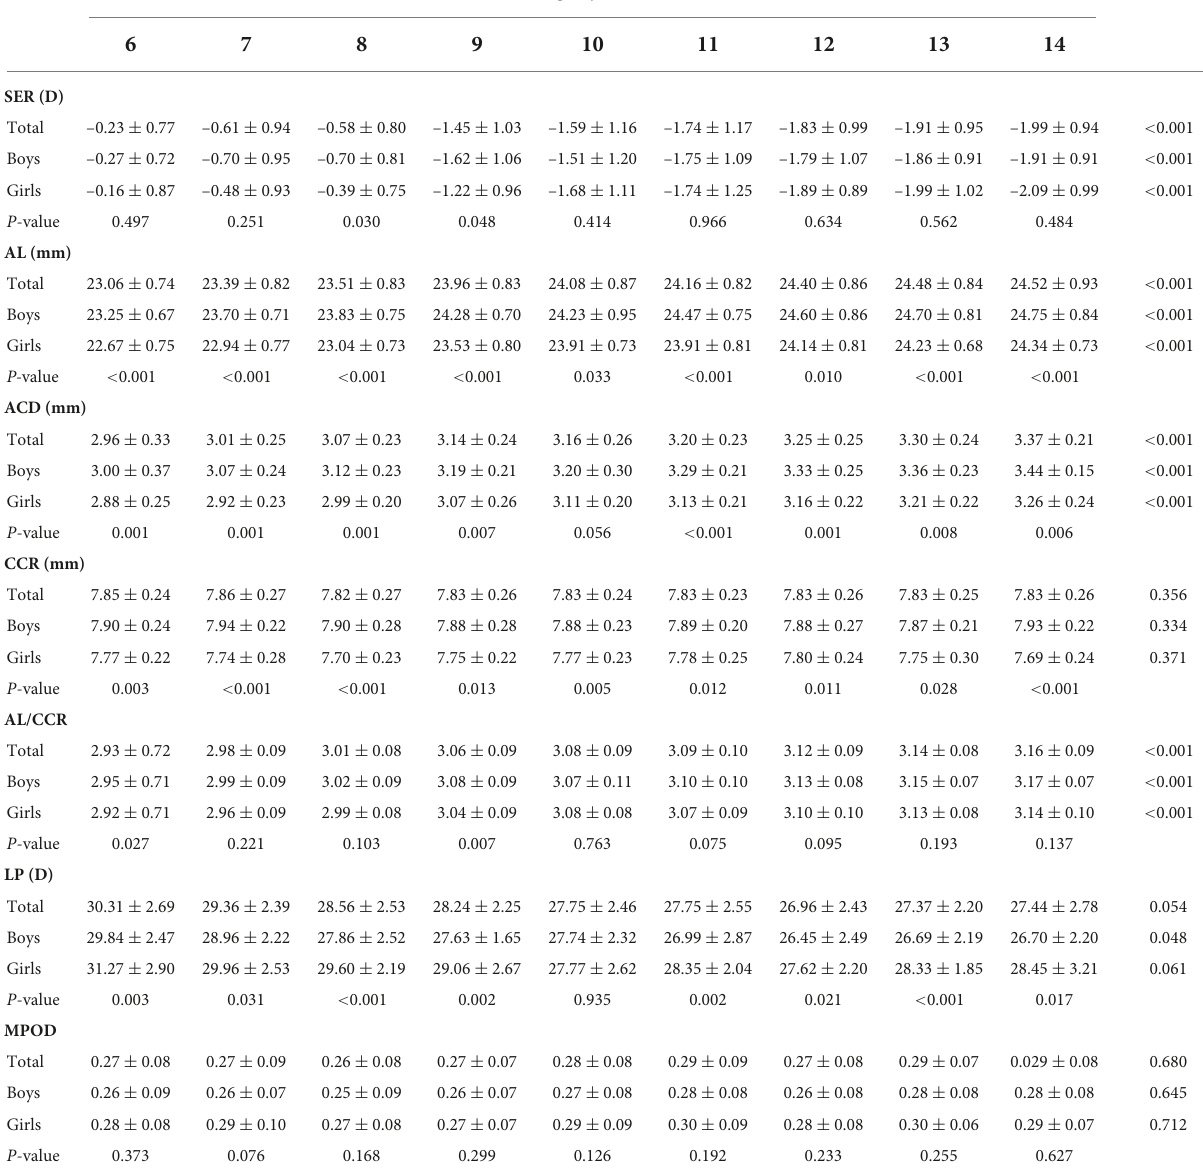
TABLE 2 Refractive and biometric characteristics of the population by gender and